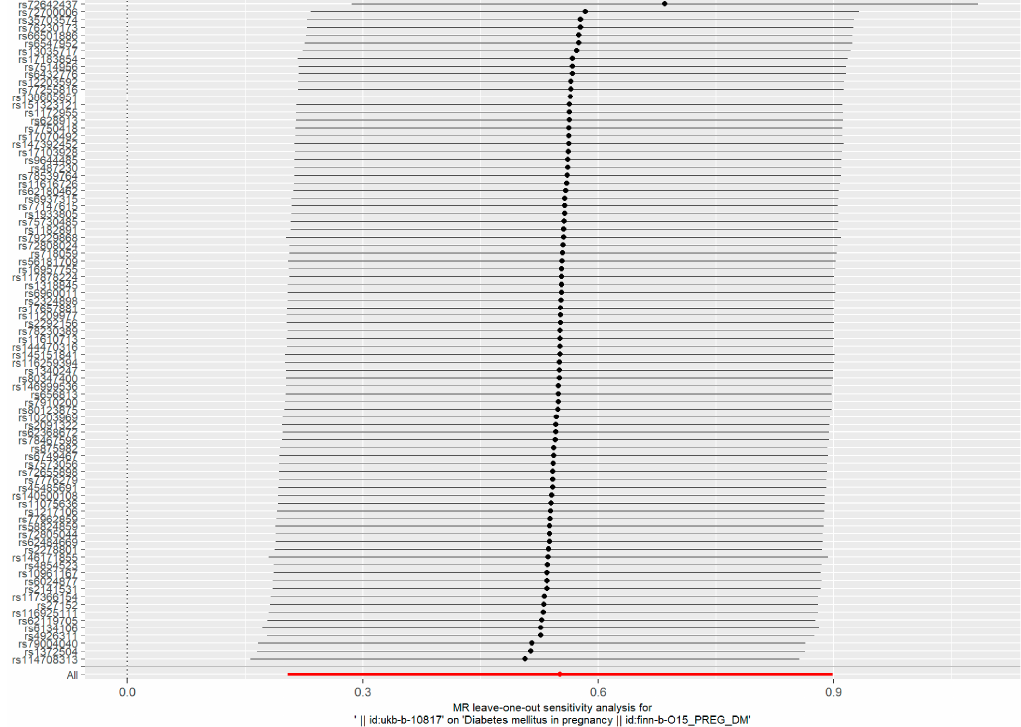
Figure 4. Forest plot of the ”leave-one-out” sensitivity analysis method to show the influence of individual SNPs on the results. The red point indicates the IVW estimates using all SNPs.